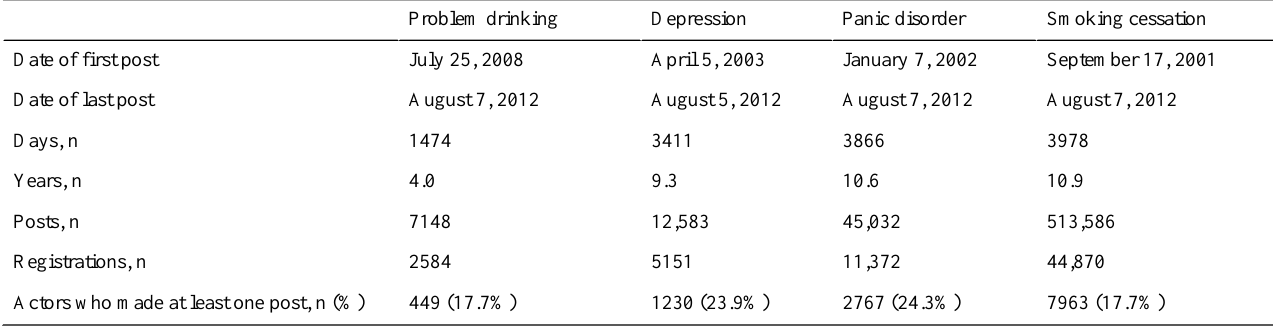
Table 1. Digital health social networks.